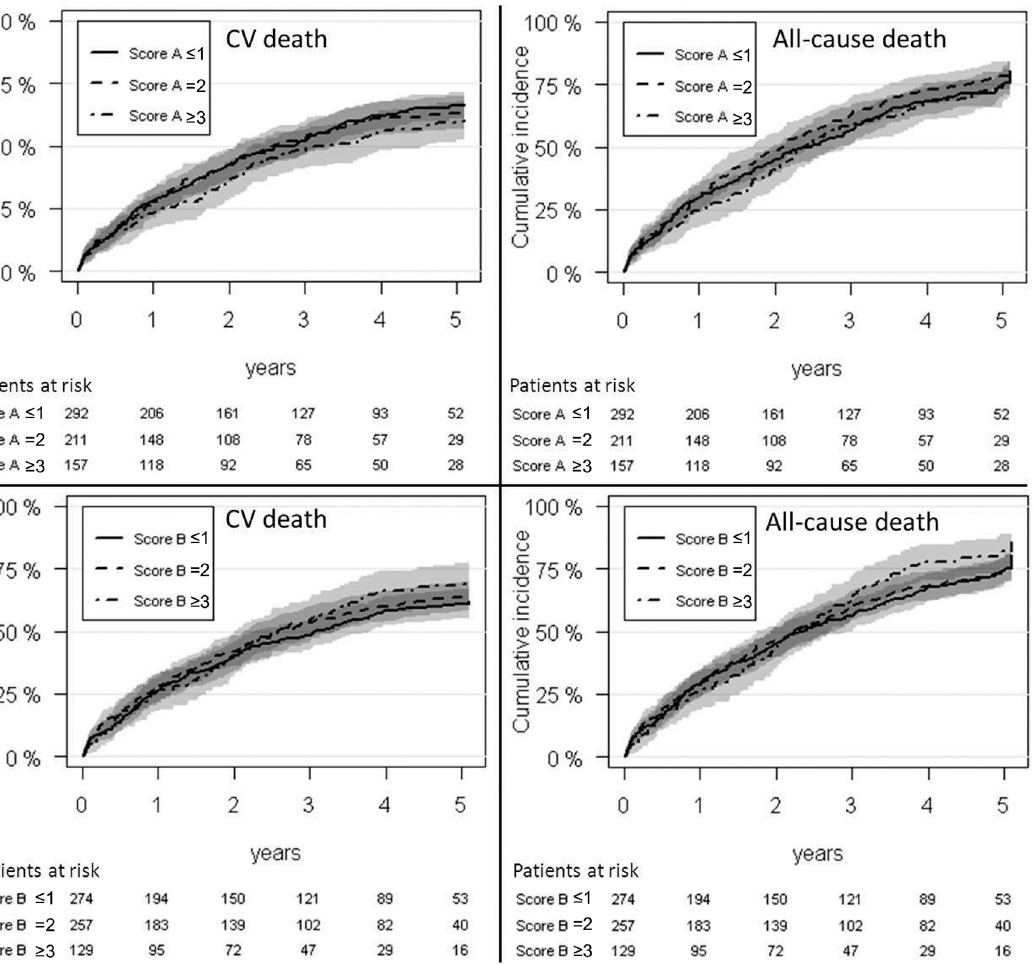
Fig 3. Cumulative incidence plots for cardiovascular (CV) death and all-cause death in angiotensin-converting enzyme inhibitor-treated patients with congestive heart failure according to genetic score A and B. The plots show the cumulative incidence estimates in % plotted against follow-up time in years. 95% confidence intervals are highlighted in gray scale nuances.